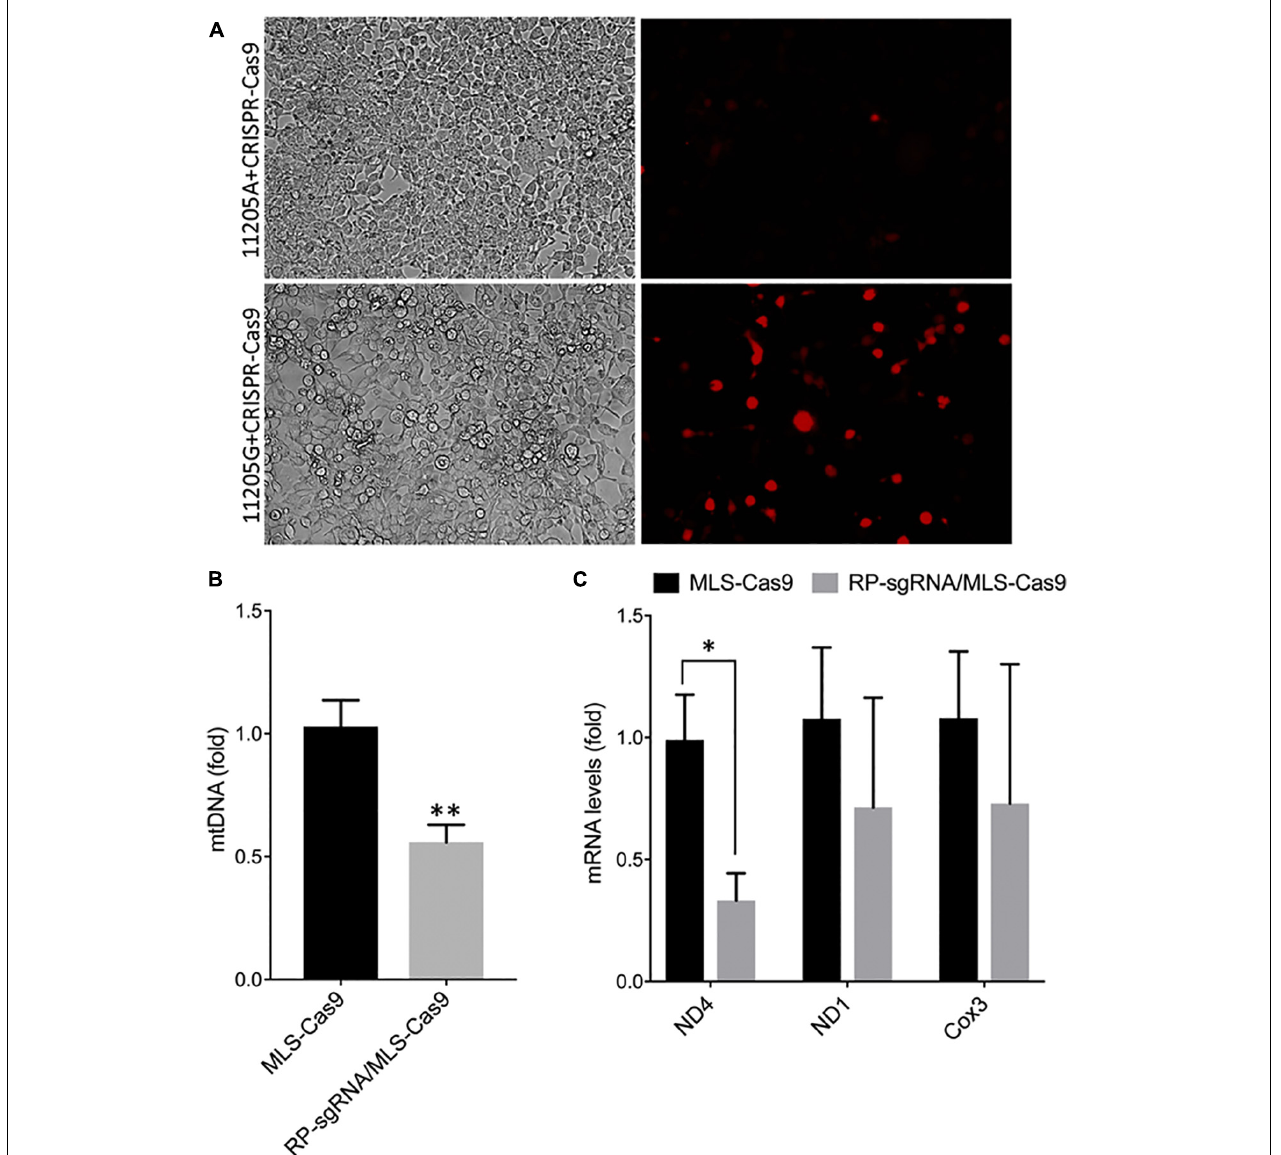
FIGURE 3 | Specificity and functionality of RP loop CRISPR/Cas9 complex. (A) Specificity of RP loop-CRSPR-/Cas9 was determined using the GeneArt R (cid:13) Genomic Cleavage Selection Kit that expressed orange fluorescent reporter, in 293K cells 72 h posttransfection, specific to the 11205G nucleotide of ND4. qPCR for mtDNA levels. (B) qRT-PCR for ND4 mRNA expression (C) was significantly lower in RP loop sgRNA-CRISPR/Cas9-transfected MEF cells, at 24 h posttransfection, compared with the MLS–Cas9 controls ( n = 5, Student’s t -test, * p = 0.016; ** p =